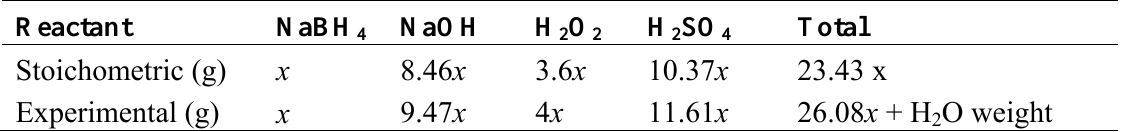
Table 1 . stoichiometrically calculated and experimentally obtained values of reactants for given amount of